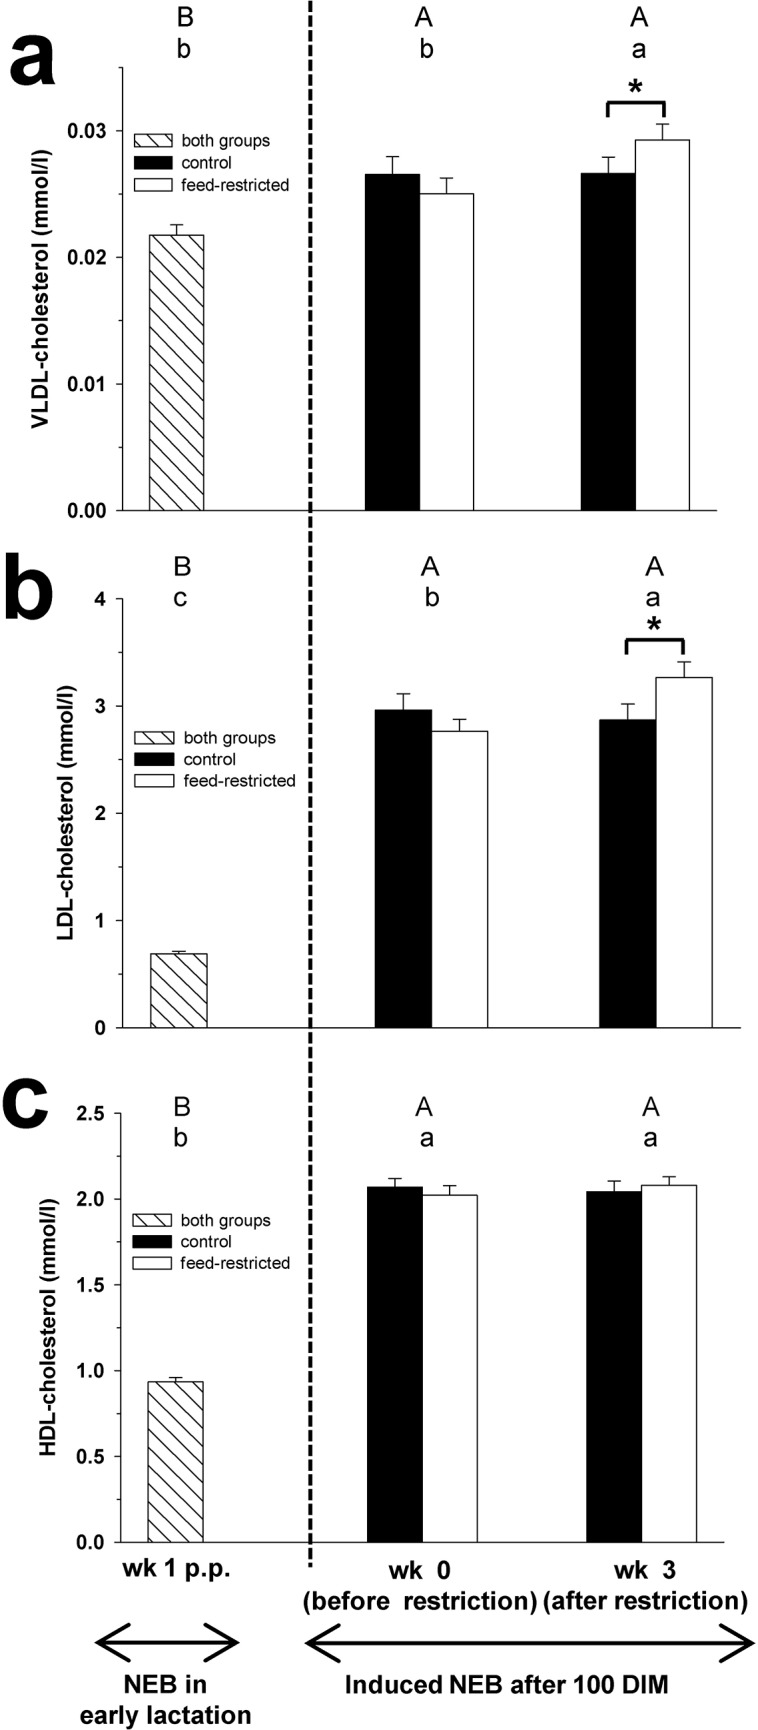
VLDL-cholesterol, LDL-cholesterol and HDL-cholesterol.Plasma concentration of VLDL-cholesterol (Fig 2a), LDL-cholesterol (Fig 2b) and HDL-cholesterol (Fig 2c) in week 1 p.p., and before (week 0) and after (week 3) feed restriction in mid-lactation. Changes over time within the groups are marked with superscripts (A to C for the control group (CON); a to c for the feed-restricted group (RES); P < 0.05). Differences between control (CON) and feed-restricted (RES) group in week 3 are indicated by * (P < 0.05). Data are presented as means ± standard error of the mean.